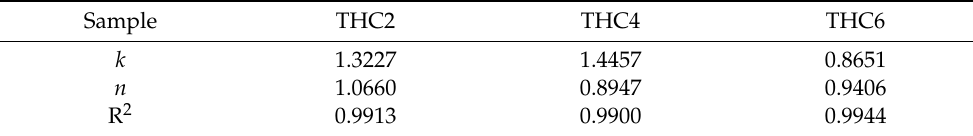
Table 2. Parameters of Korsmeyer–Peppas model for THC release from collagen scaffolds.